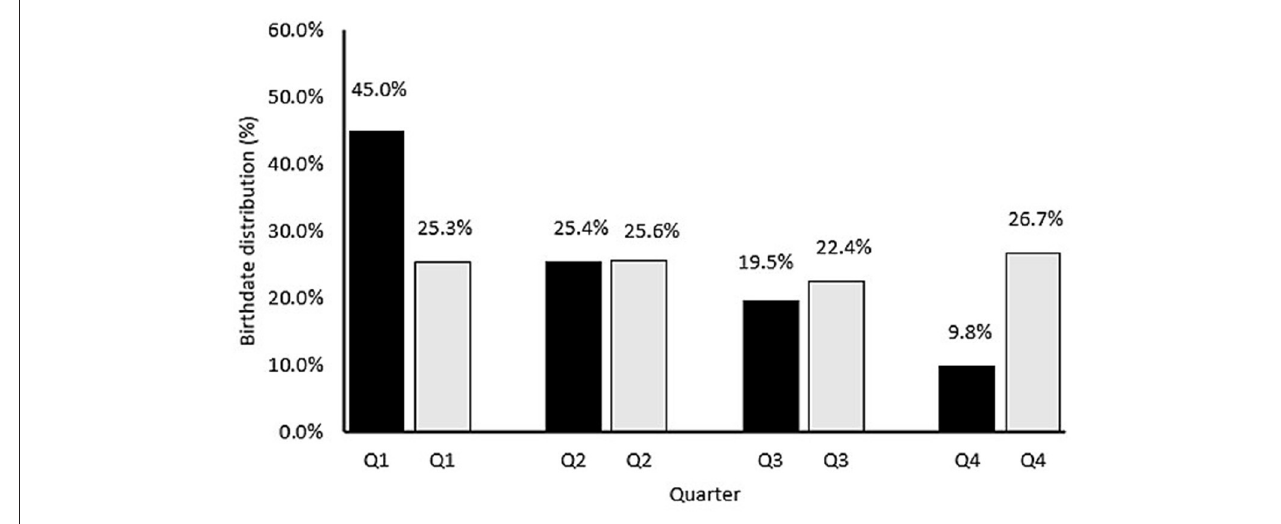
FIGURE 3 | Birthdate distribution (%) of 812 UK academy soccer players by birthdate quarter before (black) and after (gray)